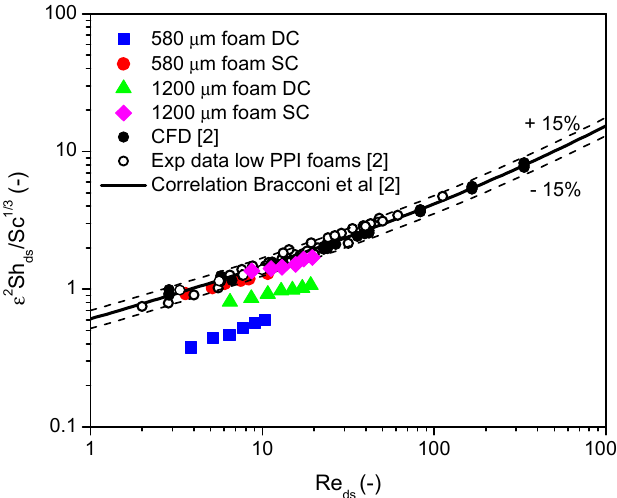
Figure 10. Comparison of mass transfer coefficients of foams prepared with spin coating and dip coating with the data presented in [2].